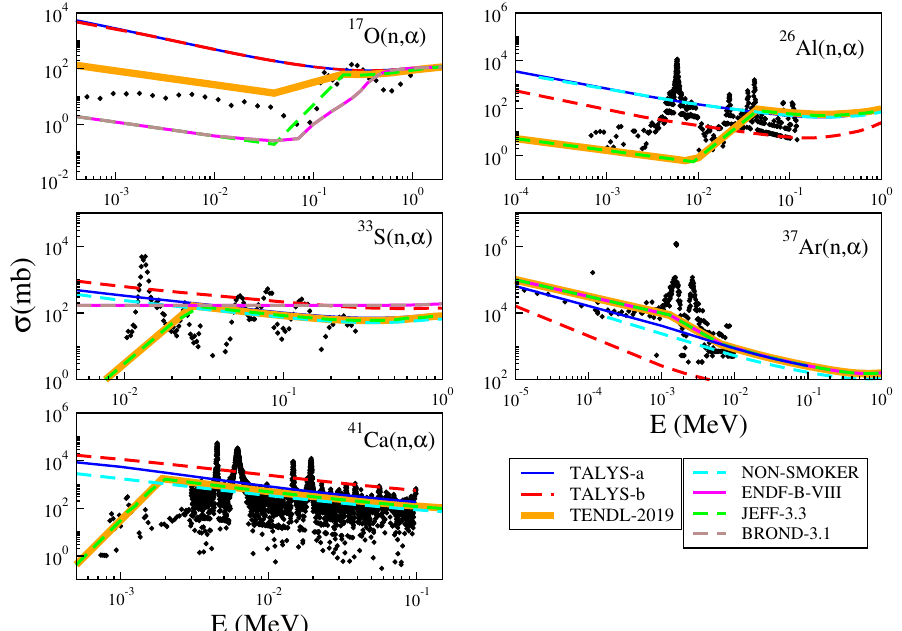
Figure 2. Comparison between the calculated and experimental ( n , α ) reaction cross sections for 17 O, 26 Al, 33 S, 37 Ar, and 41 Ca. Model calculations include experimental nuclear masses and level densities from the Fermi gas model (TALYS-a) and nuclear masses and level densities from the Skyrme functional (TALYS-b). For comparison, results from the NON-SMOKER [8] TENDL-2019 [83], ENDF-B-VIII [84], JEFF-3.3 [9] and BROND-3.1 [85] data sets are also shown. The experimental data are taken from refs.